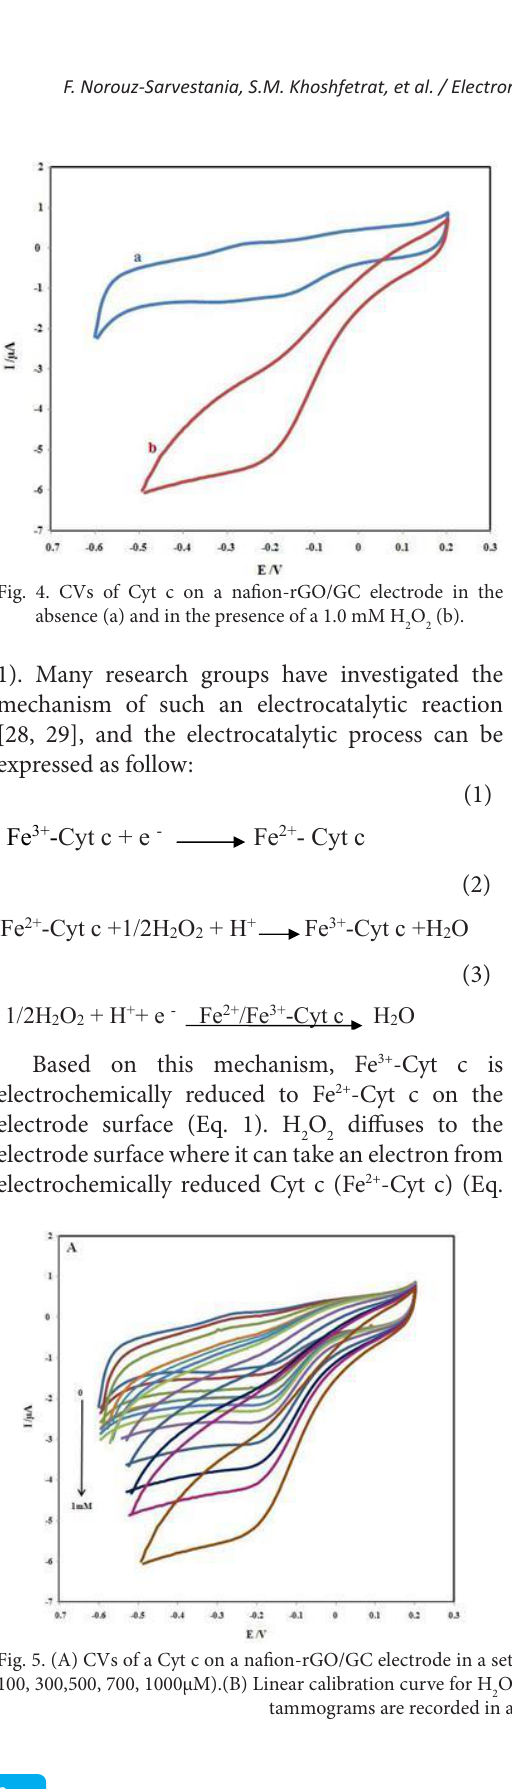
O solutions with different concentrations (0, 2, 4, 8, 10, 20,50, 2 2